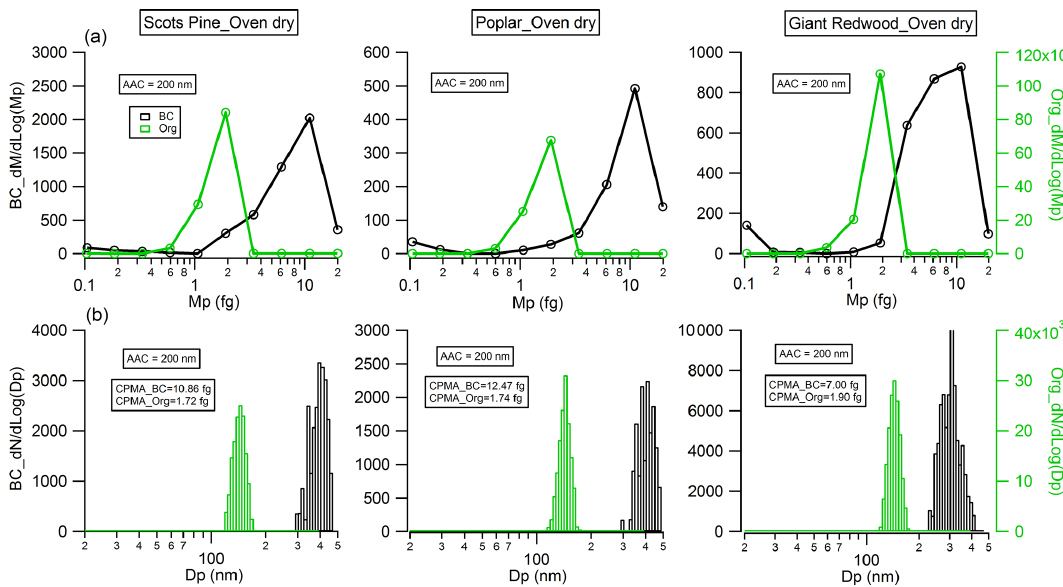
Figure 5. Physical properties of monodisperse ( D a = 200nm) black carbon (flaming phase) and organic particles (smouldering phase) emitted from wood combustion: (a) mass distribution measured by CPMA; (b) particle number distribution measured by the SMPS after the CPMA selected particles at the mass peak of the D a = 200nm particle mass distribution presented in (a)